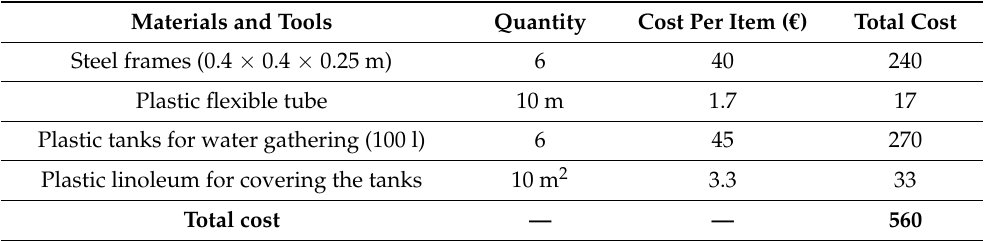
Table 2. Materials and tools that are necessary to install the runoff micro-plots and the cost of each item (Greek market, year of 2019).